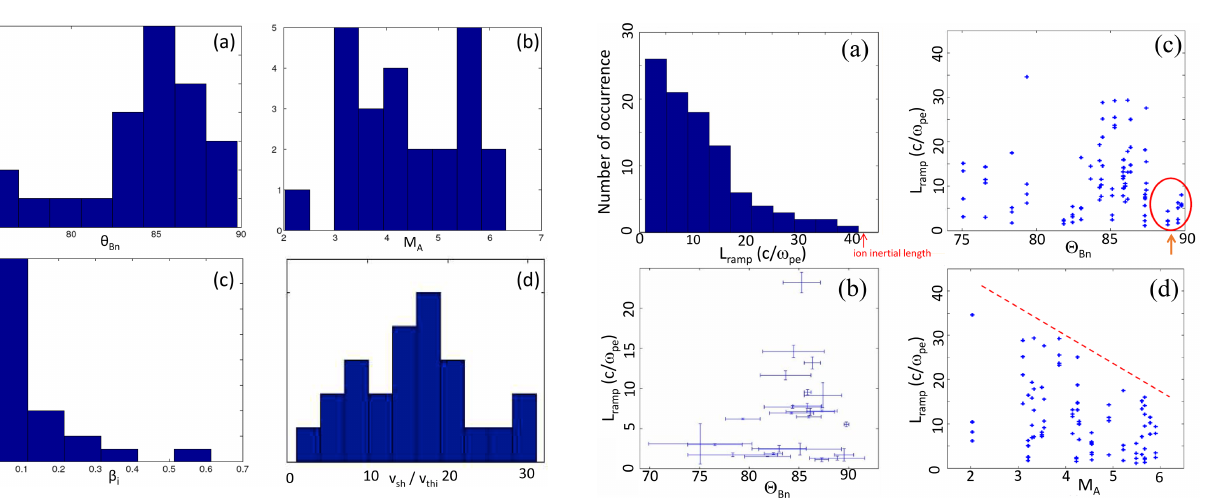
Figure 9. (a) Distribution of all ramp thicknesses measured by the four Cluster satellites during the 24 shock crossings (total covers 96 individual crossings). (b) Distribution of the thinnest ramp thick- ness observed versus the angle θ B (defined between the shock n normal direction and the upstream magnetic field); each thinnest thickness is selected among the four measurements made by the four satellites during the crossing of the same shock. Panels (a) and (b) are derived from Figs. 5 and 6 of Mazelle et al. (2010a). Distribution of all ramp thicknesses (all spacecraft measurements mixed) versus (c) the angle θ B and (d) the Alfvén Mach num- n ber ( M A = V sw , n /v A ), respectively; V sw , n and v A are, respectively, the bulk solar wind velocity along the shock normal and the up- stream Alfvén velocity. The ellipse in (c) focuses on results around = 90 ◦ ; the dashed line in (d) indicates the upper limit of the θ B n L ramp /(c/ω pe )